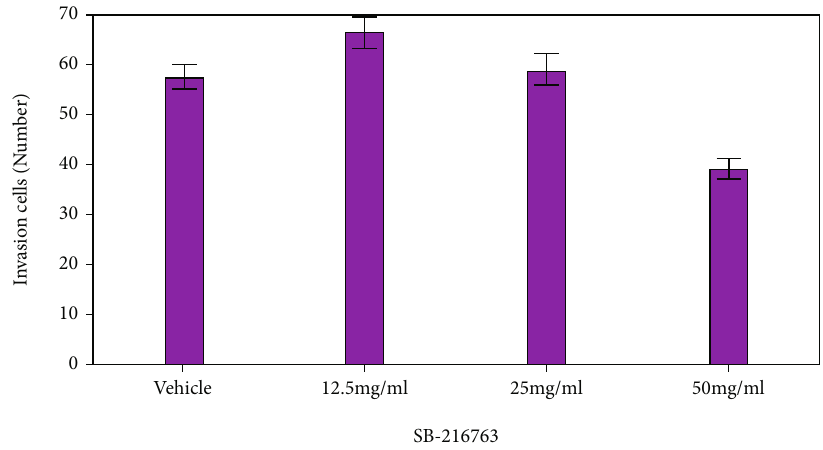
Figure 10: Stabilization of β -catenin was essential to retain the potential to metastasize.